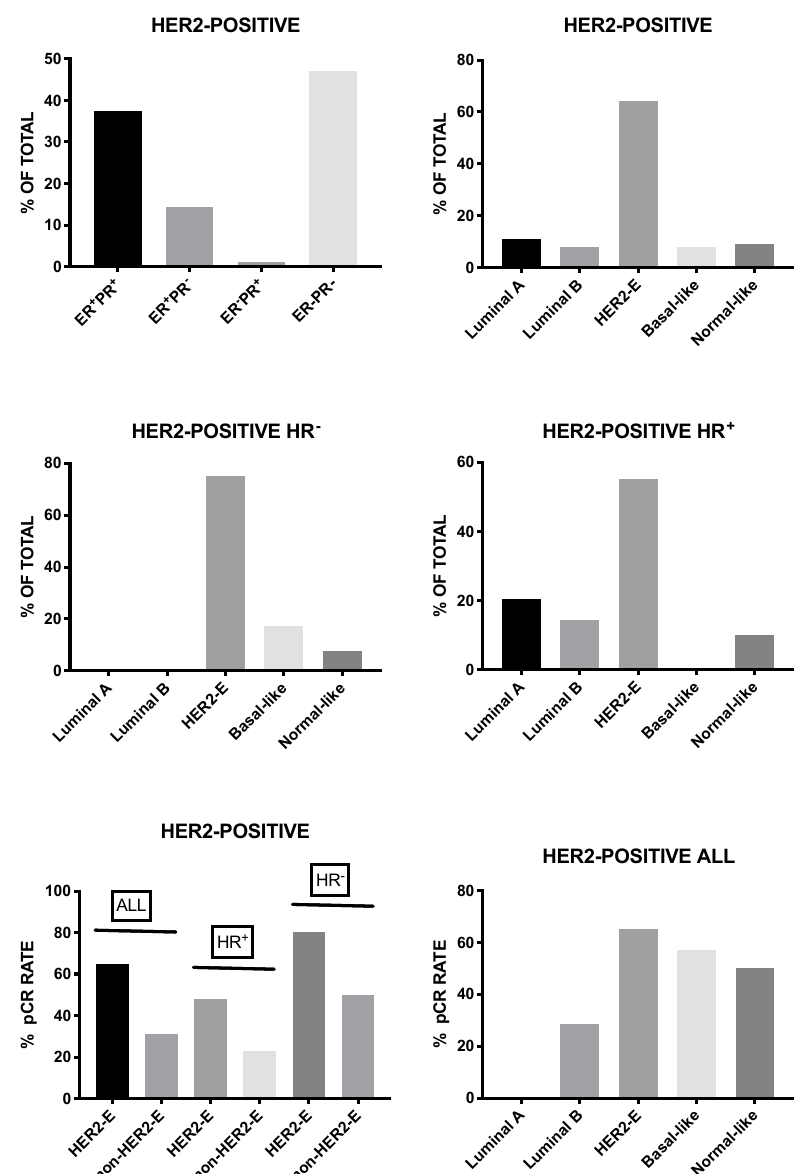
Figure 2. Hormone receptor status (top panel, left) and intrinsic subtype overall (top panel, right) or by hormone receptor status (middle panels) in a population of HER2-positive breast cancer patients undergoing neoadjuvant treatment with trastuzumab plus paclitaxel with or without lapatinib. The bottom panels report the rate of pathological complete response (pCR) observed in all HER2-positive patients (right panel) or in HER2 patients with a HER2-enriched expression subtype, subdivided according to hormonal receptor status (left panel). The data shown in this Figure are reported by Coarey et al. [85].